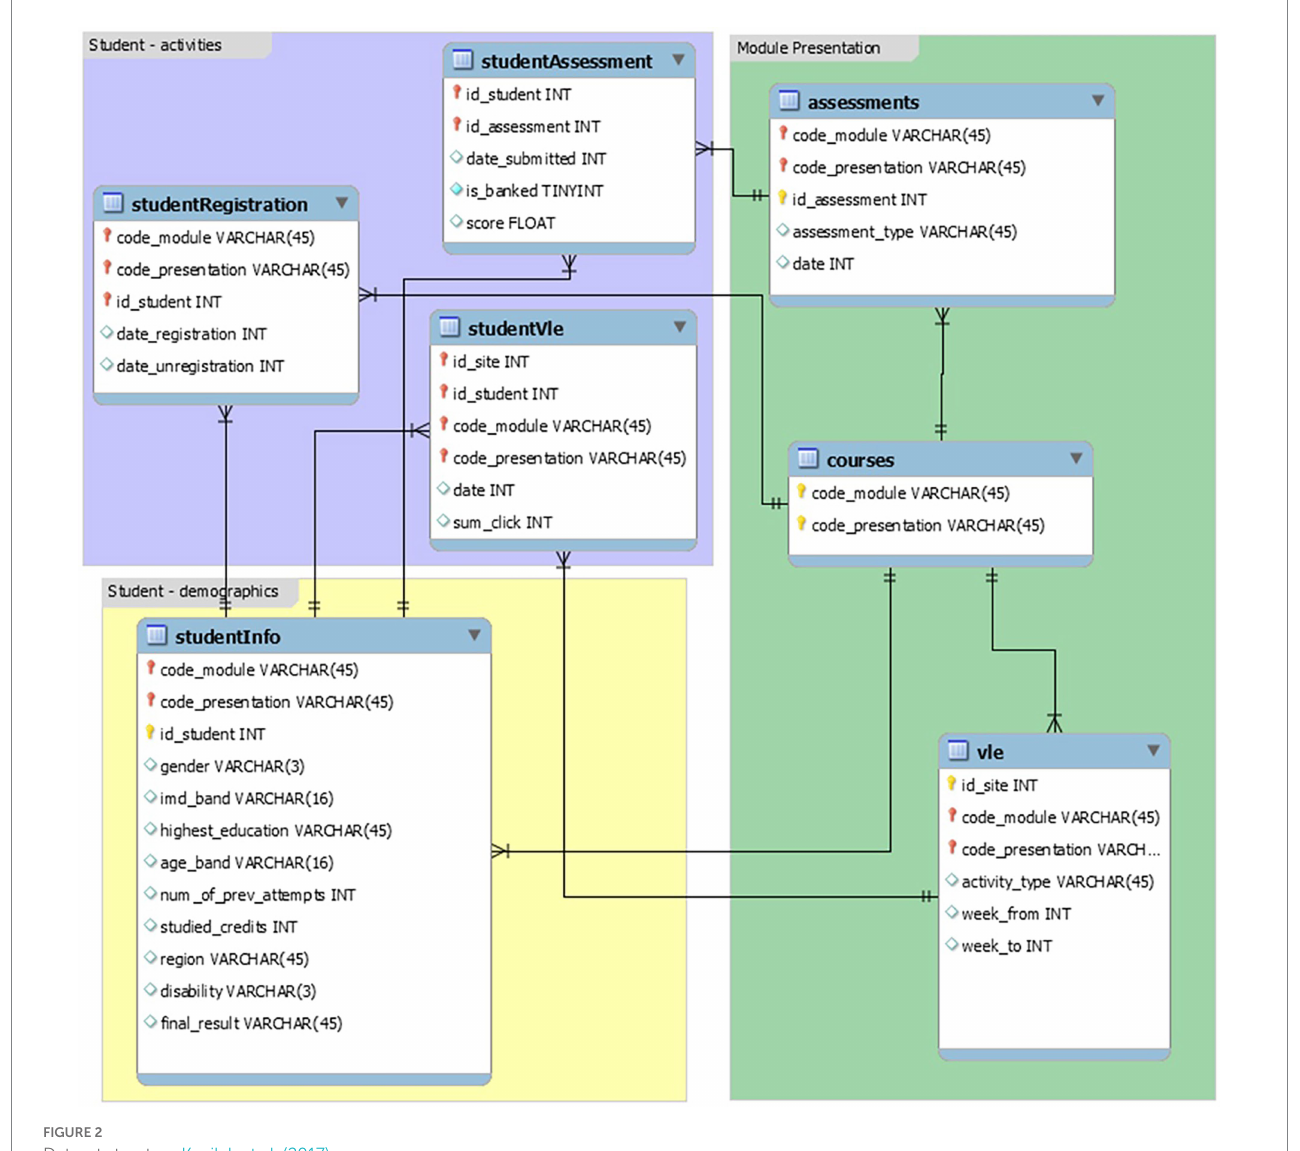
FIGURE 2 Dataset structure Kuzilek et al.